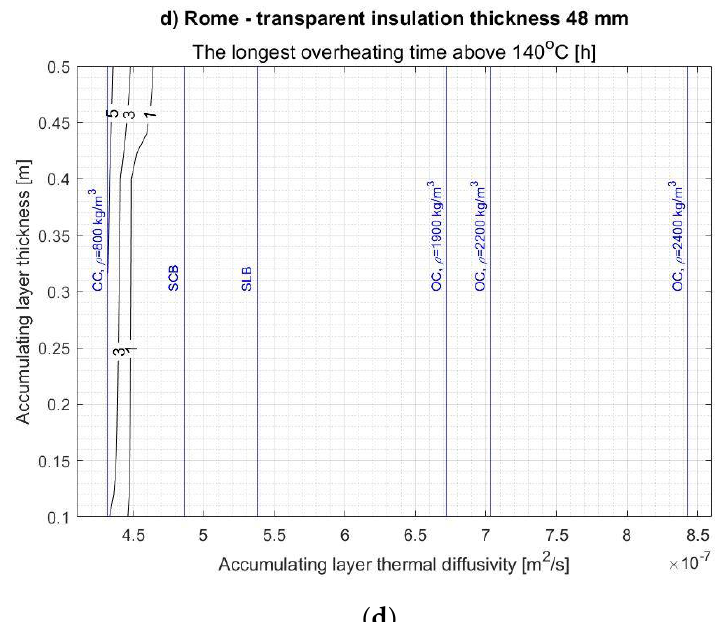
Figure A10. Contour graphs characterizing the SW basic parameters in a function of AL thermal diffusivity and thickness for the whole heating season: ( a ) the heat balance of the SW’s unit area, ( b ) the heating time, ( c ) the mean time lag of the maximum temperature on the absorber and SW’s internal surface during the day, ( d ) the longest overheating time above 140 °C in the TI. TI thickness: 48 mm. Location: Rome.